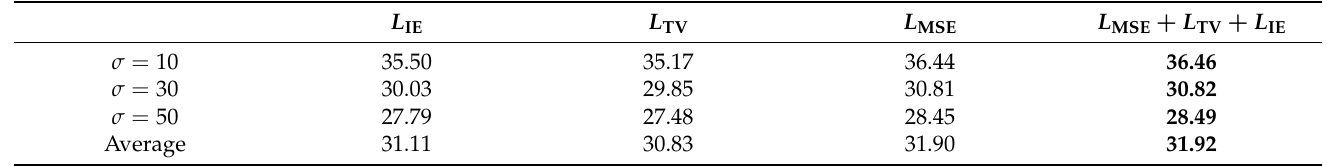
Table 3. Average PSNR values obtained by selecting different combinations of loss functions on 10 commonly used test images corrupted by different noise levels.